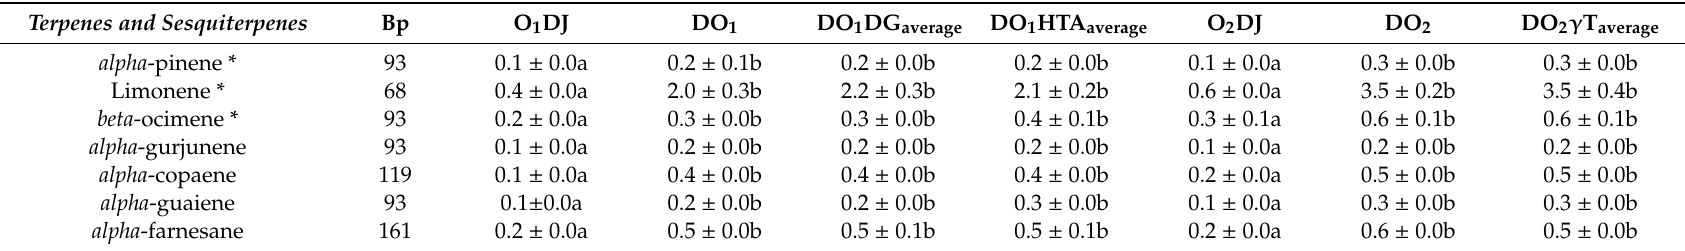
Table 6. Terpenes and sesquiterpenes of olive oil, detected by SPME-GC / MS in the headspaces of the mixture of digestive juices submitted to digestive conditions and olive oils (O 1 DJ and O 2 DJ), of the digestate of these oils (DO 1 and DO 2 ) and of the samples enriched with di ff erent levels of dodecyl gallate, hydroxytyrosol acetate, and gamma -tocopherol (DO 1 DG, DO 1 HTA, DO 2 γ T). Data are average abundances expressed as area counts of the mass spectra base peak (Bp) of each compound multiplied by 10 -6 , together with their standard deviations. For samples enriched with phenolic compounds data given are average values of the abundances of the headspace of digestates coming from samples having di ff erent enrichment levels of phenolic compounds. Di ff erent letters within each row of each oil indicate statistically significant di ff erences among the samples ( p <